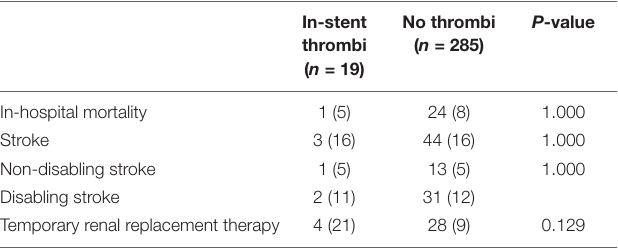
TABLE 3 | Thrombus characteristics. TABLE 4 | Postoperative and follow-up outcome.